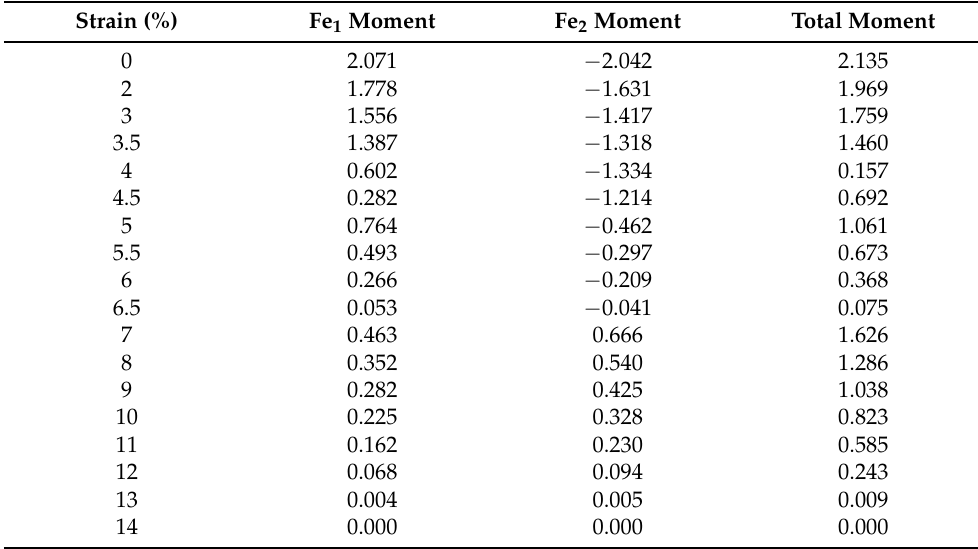
Table 3. Magnetic moments (in µ B ) of iron atoms on two sites, Fe 1 and Fe 2 , and total magnetic moments per Fe 3 Se 4 formula unit of Fe 3 Se 4 under compression. The Wigner–Seitz radius for Fe ions is 1.302